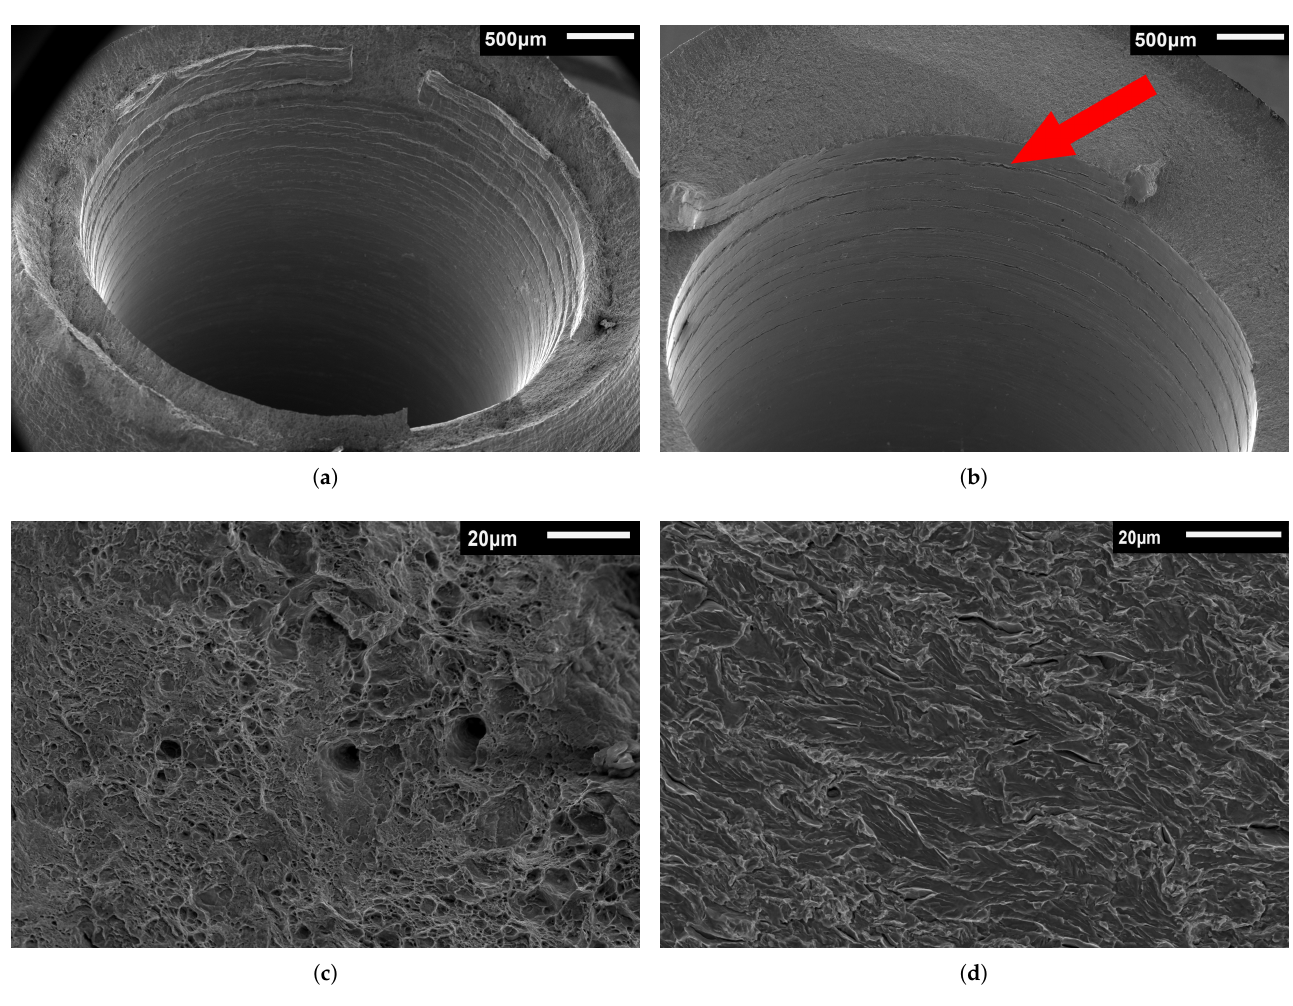
Figure 9. SEM Fractographic images of notched base metal samples. ( a ) Tested in 100 barg N 2 . ( b ) Tested in 100 barg H 2 . ( c ) Higher magnification image of smooth base metal samples tested without gas. ( d ) Higher magnification image of smooth base metal samples tested in 100 barg H 2 . Secondary cracks parallel to the fracture surface are present on the inside surface of the sample in ( b ), as indicated by the